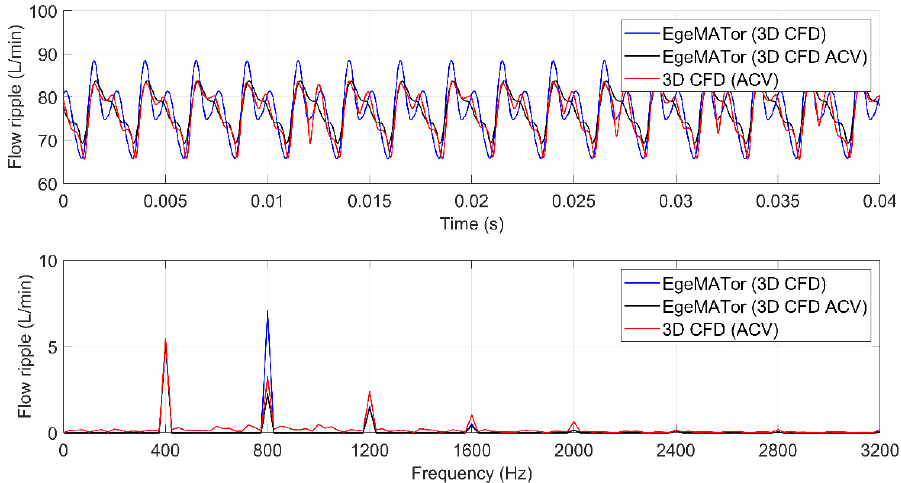
Figure 15. Outlet flow ripple at 1500 rev/min and 230 bar in time and frequency domains.